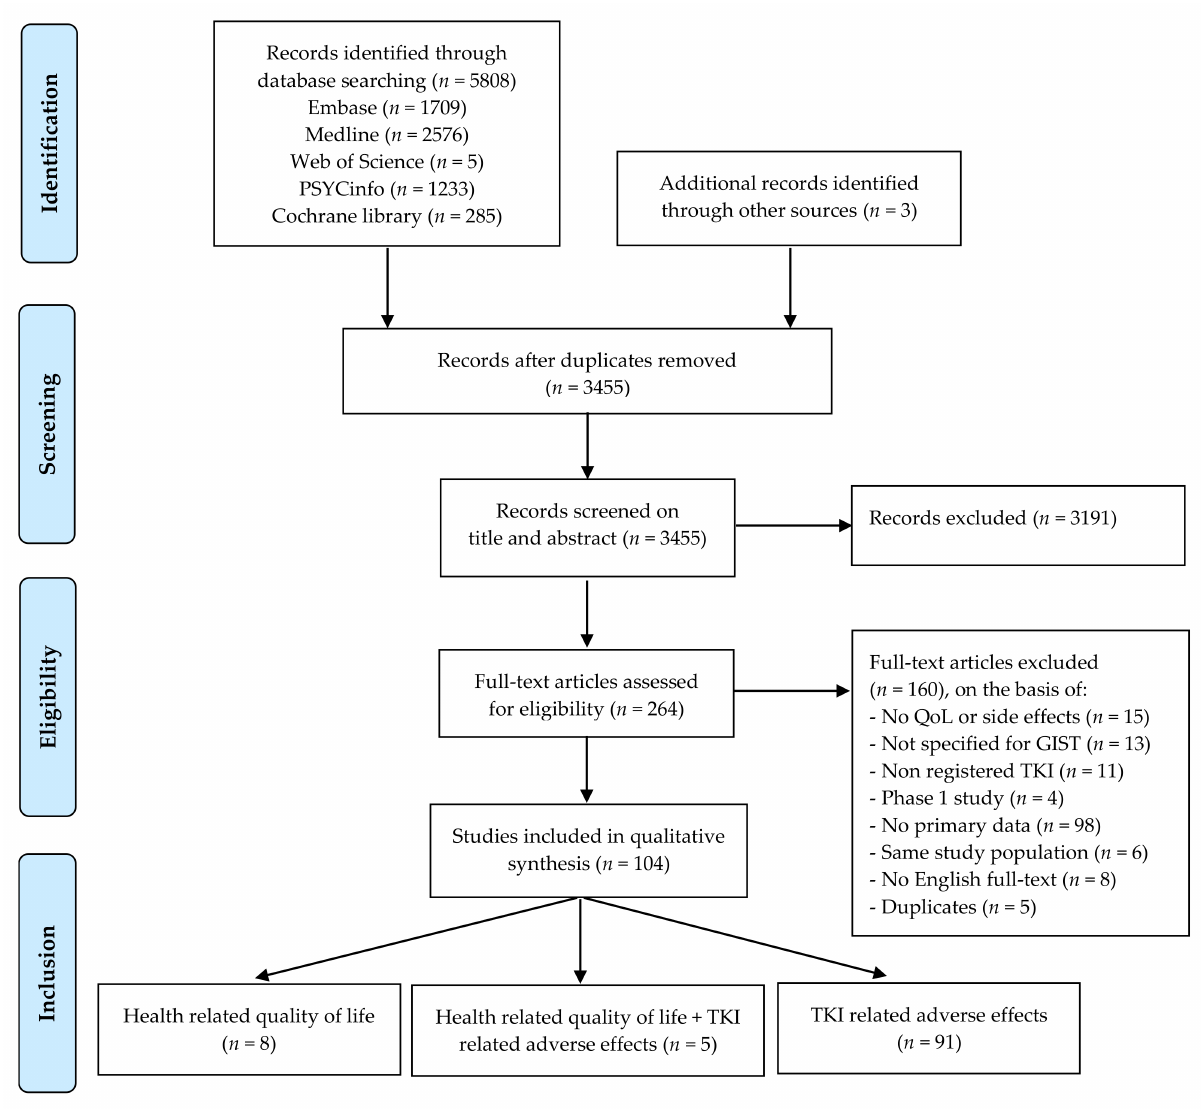
Figure 1. Flow chart of the selection